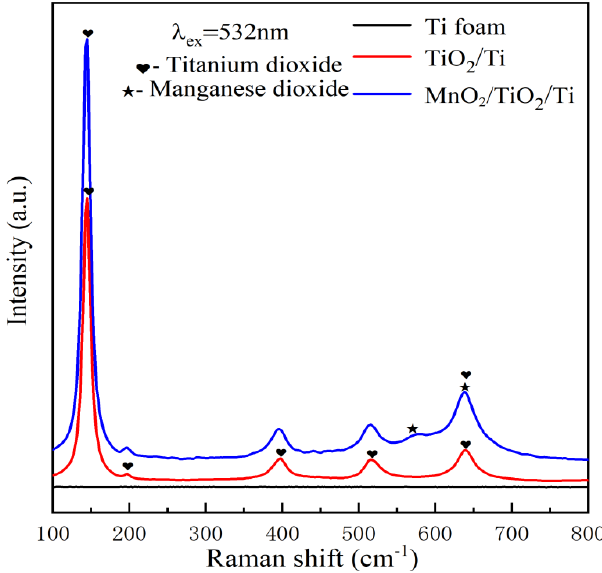
Figure 2. Raman spectroscopy test results of commercialized metal porous Ti, surface−modified TiO 2 /Ti, and MnO 2 /TiO 2 /Ti nanocomposites.